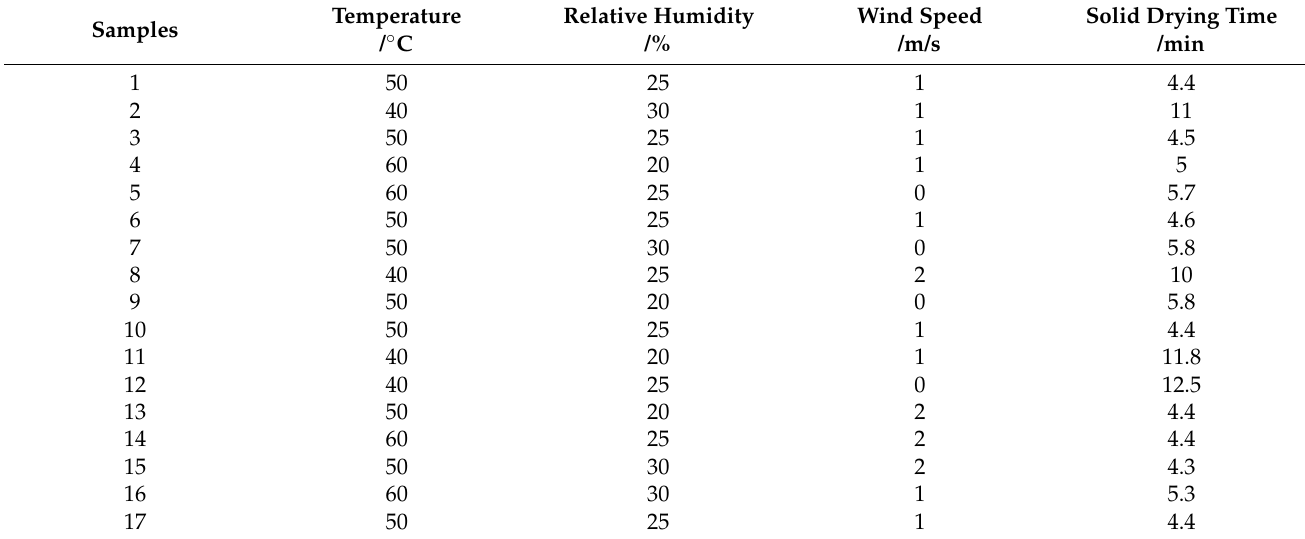
Table 4. Results of the solid drying time.